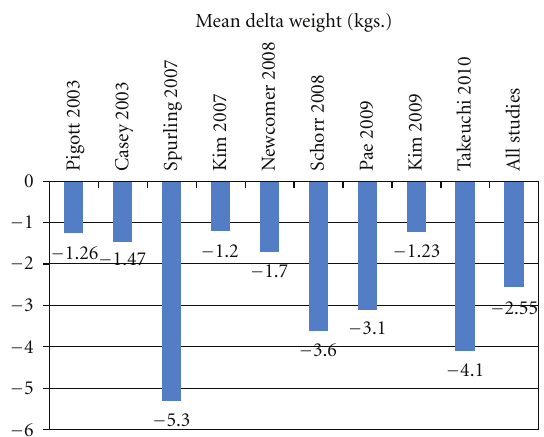
Figure 1: Mean reduction in weight (kgs) across analyzed